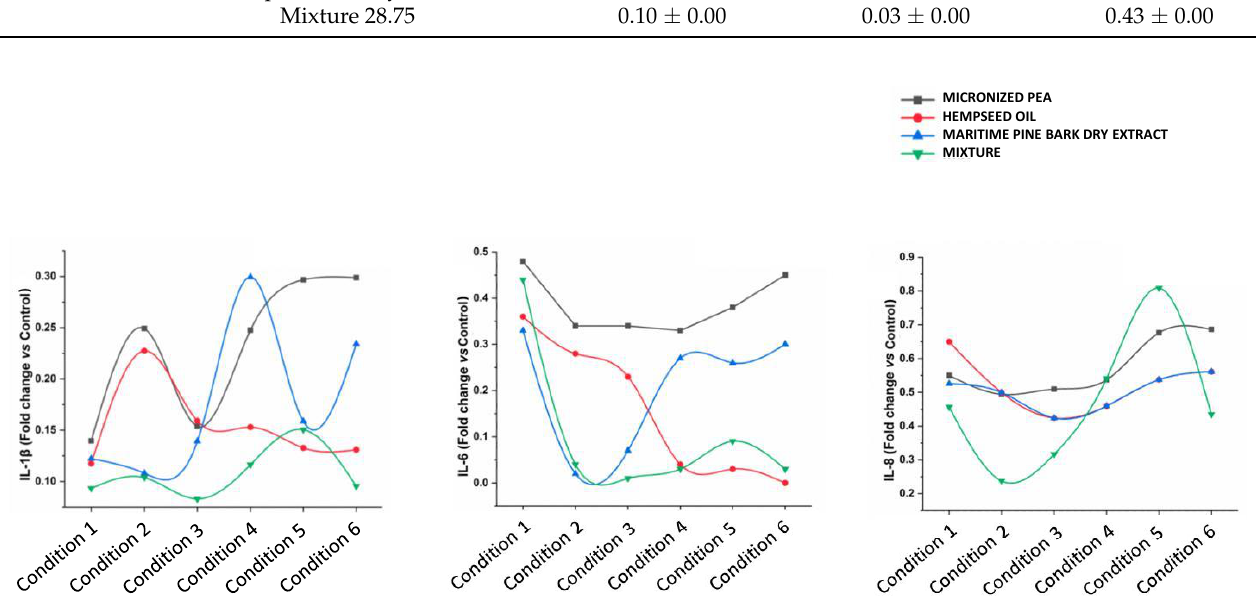
Figure 5. Effects of individual components and their mixture on IL-1 β , IL-6, and IL-8 levels in different conditions.